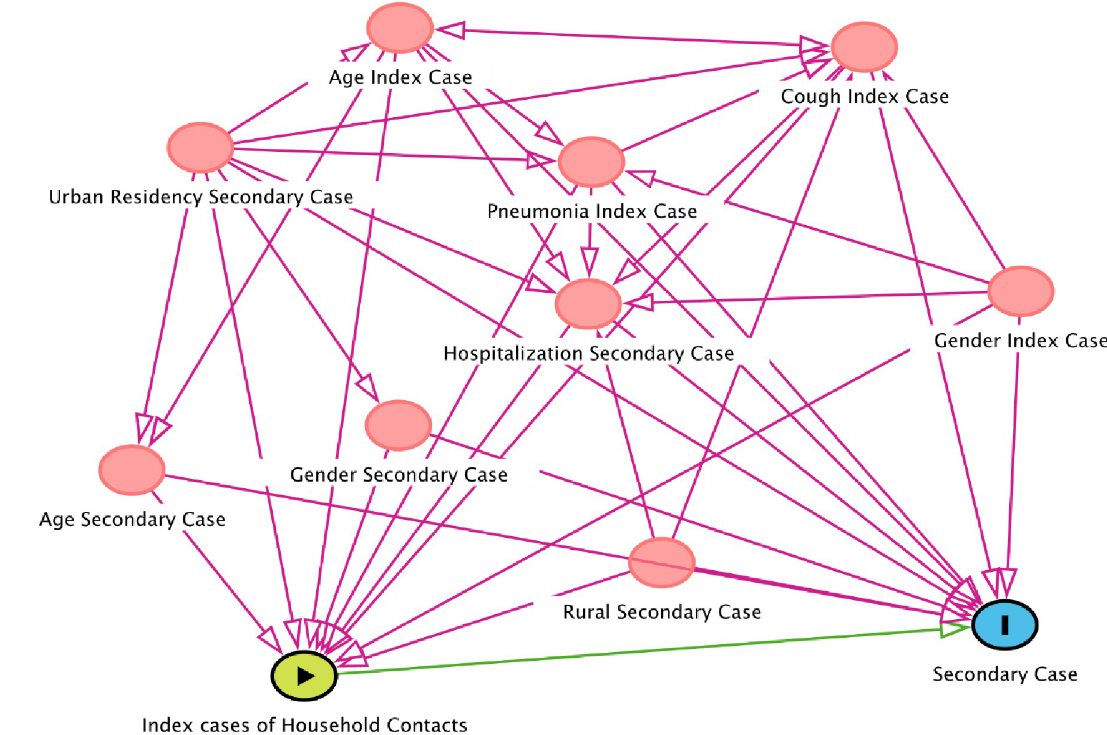
Fig 1. Directed Acyclic Graph (DAG) of Pakistani household index case (exposure) contacts effect on the COVID-19 secondary cases (outcome). Ancestors of outcome (red color) and exposure.